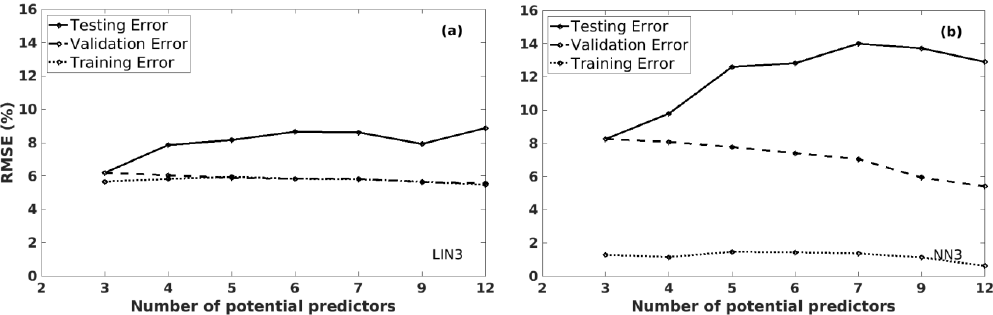
Figure 10. The training, validation, and testing RMSE values of the predicted grain maize yield anomalies, using different models by increasing the number of potential predictors, in Bas-Rhin (France): (a) LIN3 and (b) NN3 (with n neuron = 7) models.